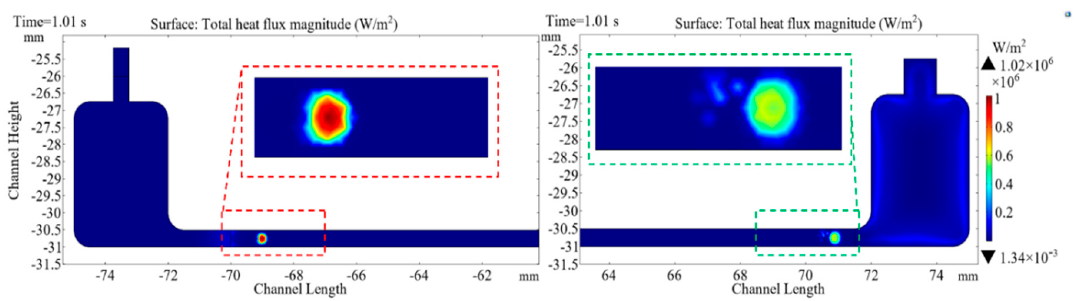
Figure 12. Heat flux distribution with constant temperature on channel walls.